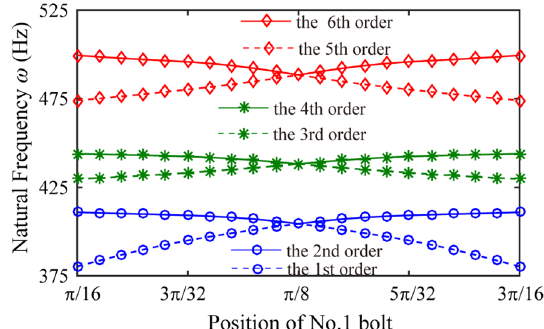
Figure 10 Effect of the position of only one mistuned bolt (No.1 bolt) on the first six natural